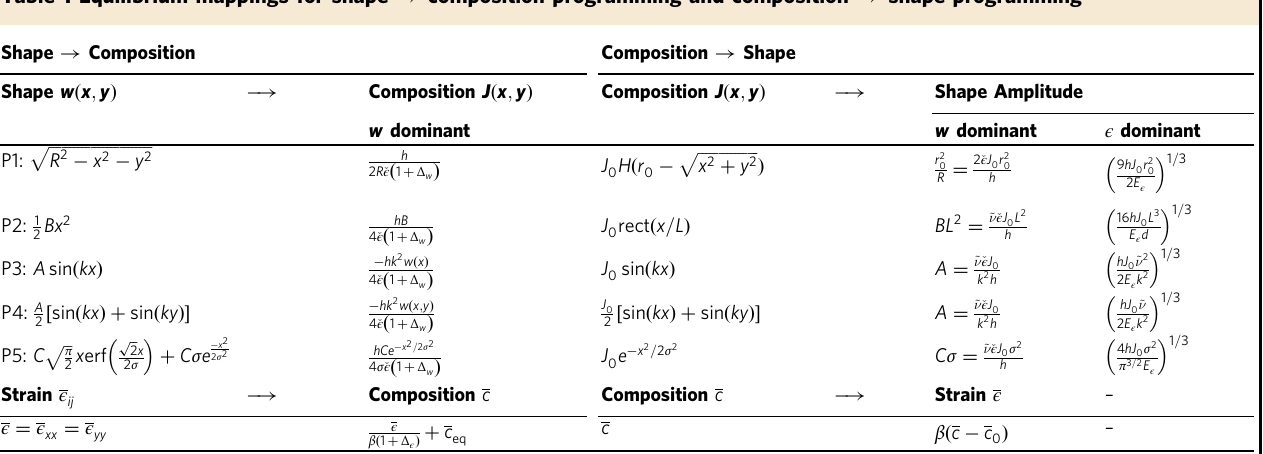
1 = Δ w for Δ w (cid:10) 1. 0 (cid:3)